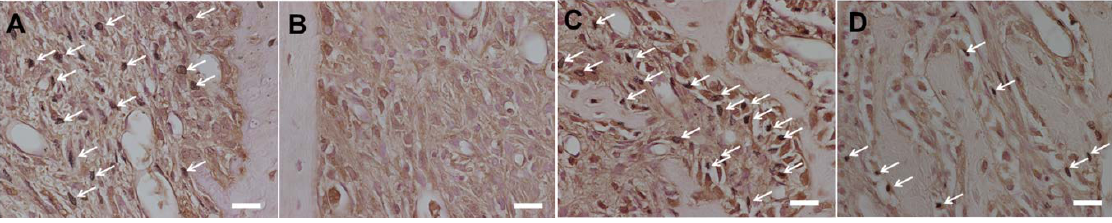
Figure 6. Photographs of alveolar socket stained with 8-OHdG (Scale bar = 20 μm). Photographs of upper region are shown ( A : 3-days control group; B : 3-days experimental group; C : 8-days control group; D : 8-days experimental group). 8-OHdG-positive cells were stained brown (white arrows). Expression of 8-OHdG in the upper region was lower in the experimental group than in the control group at 3 and 8